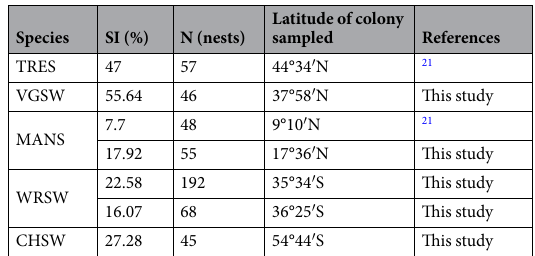
Table 5. Female breeding synchrony and latitude for the seven populations of Tachycineta species used in this study. SI: synchrony index calculated following 49 ; N: number of nests sampled. TRES = Tree swallow, VGSW = Violet-green swallow, MANS = Mangrove swallow, WRSW = White-rumped swallow, CHSW = Chilean